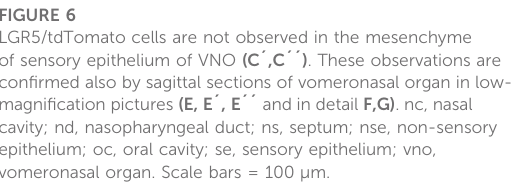
FIGURE 6 LineagetracingofLGR5-positivecellsduringdevelopmentof vomeronasal organ. Timeline of tamoxifen application and collection of embryos (A) . Low-magni fi cation image of VNO after tamoxifen induction and embryos collection at E18.5. LGR5/ EGFP positive cells are represented by green color, LGR5/ tdTomato positive cells are represented by red color and the overlap of LGR5/EGFP positive cells and LGR5/tdTomato positive cells is represented yellow color (B) . Higher-magni fi cation of lineage tracing in the VNO area (C-D´´) . The LGR5/EGFP positive cells are situated in the mesenchyme underlying the lateral non- sensory epithelium, several cells are localized also around sensory